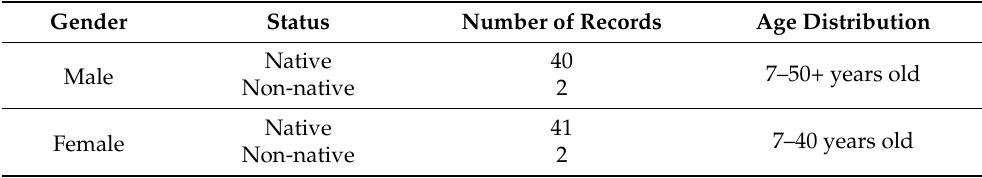
Table 1. Summary of data collection from